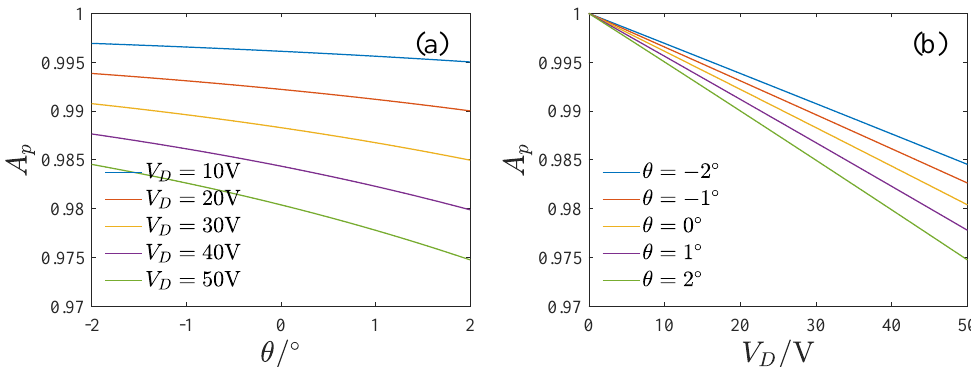
Figure 9. The influence of the DC voltage and the inclination angle on the pull-in boundary amplitude. ( a ) The influence of the DC voltage, ( b ) The influence of the inclination